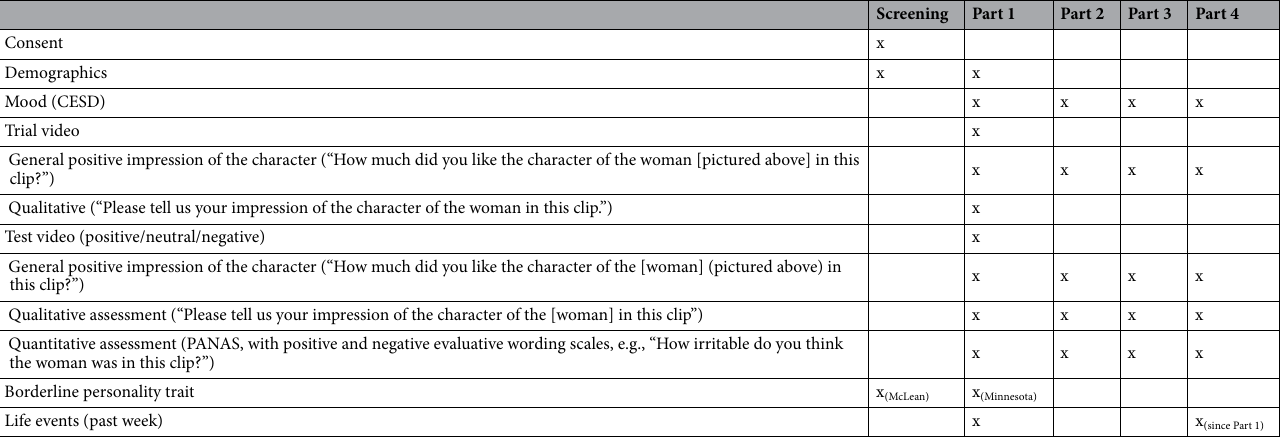
Table 1. Measurements at each stage of the study. Part 1 immediately followed screening; Part 2 was offered 2 days thereafter; Part 3 two days after Part 2; and Part 4 two days after Part